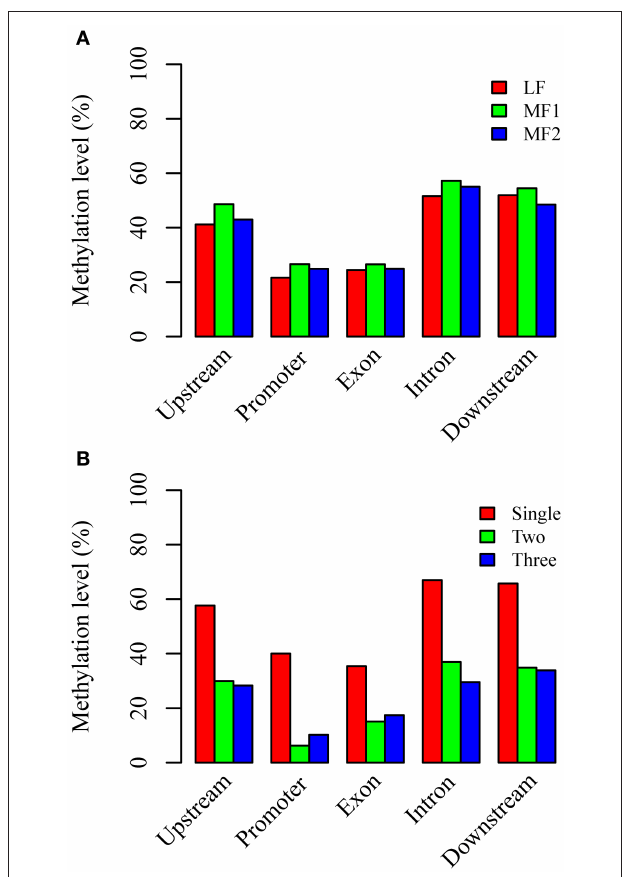
FIGURE 3 | Average CG methylation levels in different components of genic regions (A) between three subgenomes and (B) between different copy genes. Whereas, promoter regions are defined as 200 bp regions before TSS site, upstream or downstream regions are defined as 1000 bp before TSS or after TTR